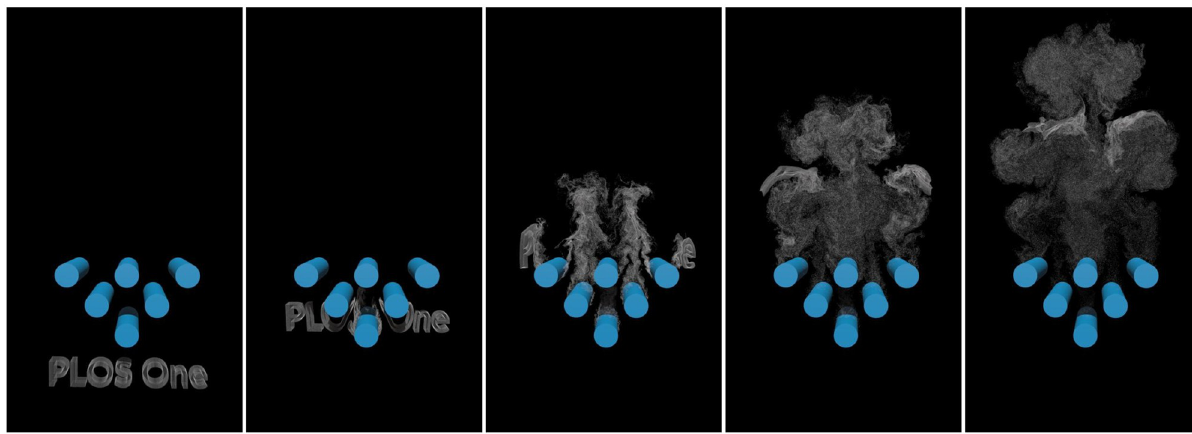
Fig 13. Smoke forming the words ‘PLOS One’ and passing through some obstacles.